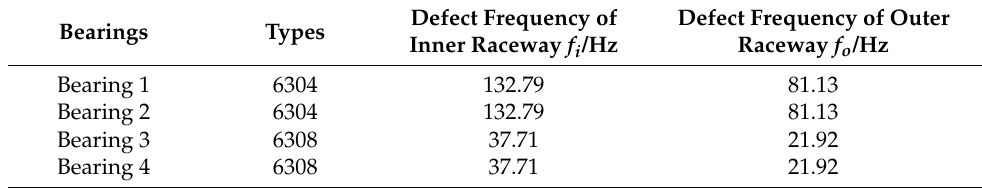
Table 1. Bearing types and defect frequencies.